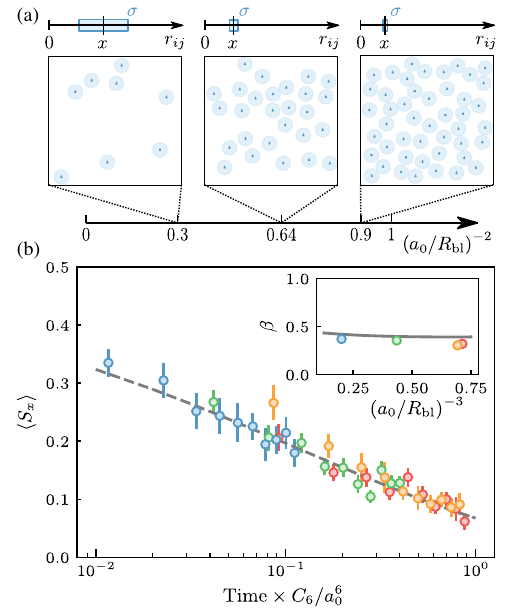
FIG. 5. Rescaled magnetization dynamics for different densities and disorder strengths. (a) 2D representation of a spin system with different densities and thus strengths of disorder, characterized − 2 . by the mean number of spins per blockade radius ð a 0 =R bl Þ The bar denotes the mean x and standard deviation σ of the r interparticle distances min . (b) Data points represent mea- i ≠ j ij surements of the averaged magnetization h S for spin densities x i ρ 0 ¼ 0 . 43 ð 11 Þ × 10 9 cm − 3 (blue), 0 . 8 ð 2 Þ × 10 9 cm − 3 (green), S 1 . 2 ð 3 Þ × 10 9 cm − 3 (orange and red, corresponding to two differ- ent datasets). By rescaling time with the effective interaction strength C 6 =a 6 0 , the data collapse on a single curve described by a stretched exponential function with stretching exponent β ¼ 0 . 32 ð 2 Þ (dashed line). The inset shows β as a function of the − 3 for the experimental data and corresponding ratio ð a 0 =R bl Þ DTWA calculations (solid gray